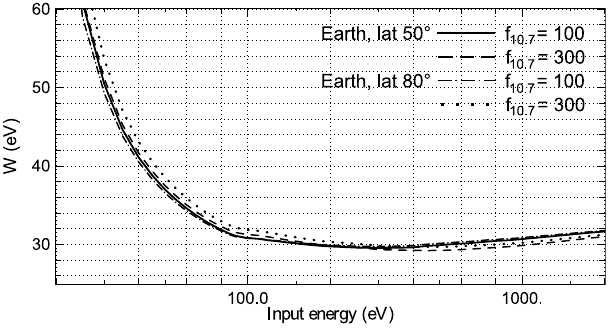
Fig. 2. Latitudinal and solar activity variations of W net for Earth. Results for latitude 50 ◦ and 80 ◦ are shown for low and high solar